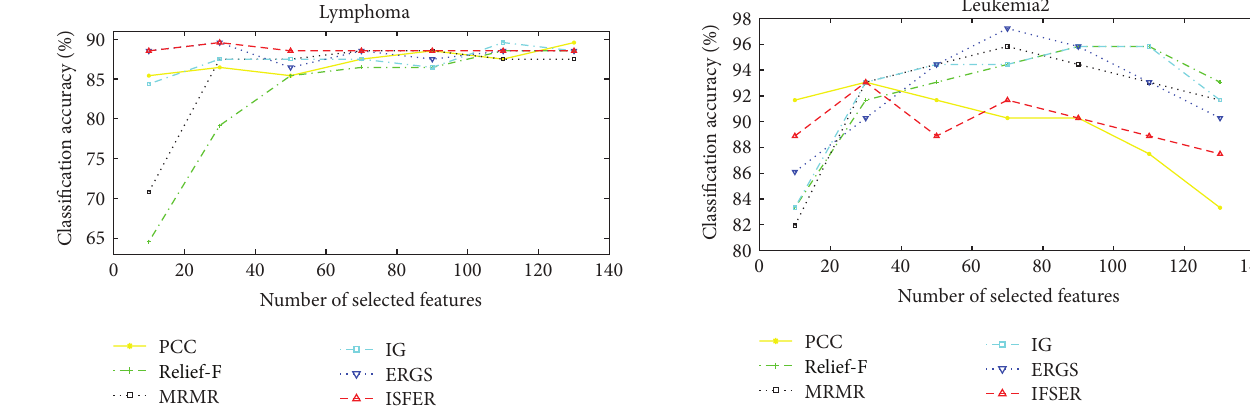
Figure 3: The classification accuracies of different algorithms on the Lymphoma database.